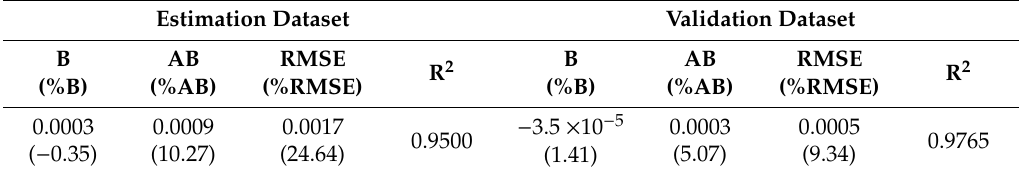
Table 13. Statistical indexes for the mean tree volume, V , (m 3 ) model, using the mixed-e ff ect scenario. Estimation